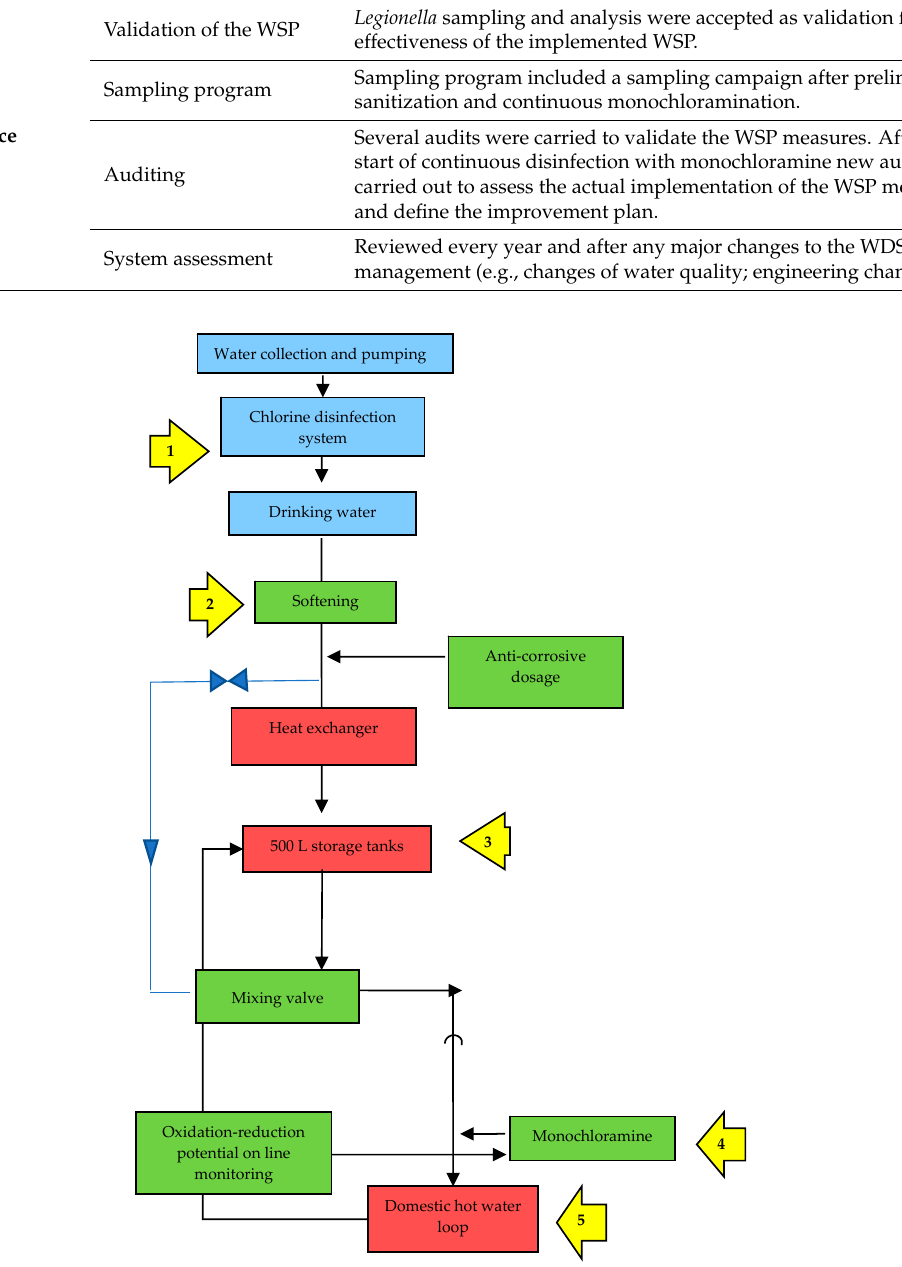
Figure 1. The main critical control points (CCPs) for the control of Legionella identified at the hospital ‘Santa Marta e Santa Venera’ throughout the water distribution system.